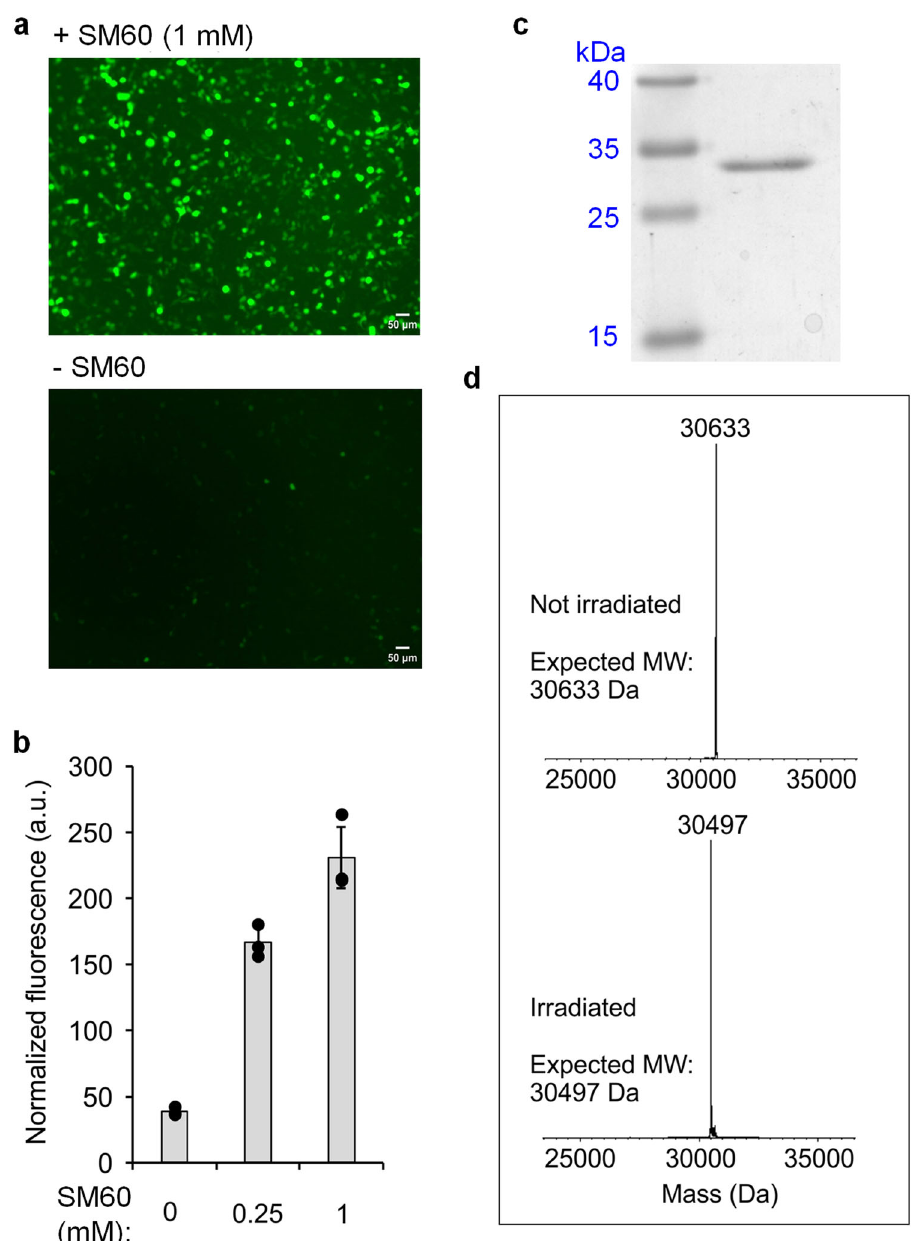
Fig. 2 Site-speci fi c incorporation of SM60 in EGFP and subsequent conversion to citrulline in HEK293T cells. a EGFP-39-TAG reporter expression by EcLeuRS-tRNA CUA EcLeu pair in HEK293T cells in the presence of SM60 indicated by the fl uorescence of EGFP. b Quanti fi cation of EGFP-39-TAG reporter expression ef fi ciency in the presence of an increasing concentration of SM60. n = 3 independent experiments, data are presented as mean value ± SD. The solid circles represent data points for biologically independent replicates. Source data are provided as a Source Data fi le. c Coomassie stain of puri fi ed EGFP containing SM60. Full gel is given in Supplementary Fig. 7. d Deconvoluted mass spectrum of EGFP before and after 365 nm UV irradiation (1 min), indicating the presence of SM60 and citrulline, respectively, at position 39. Non-deconvoluted spectra are given in Supplementary Figs. 8 and